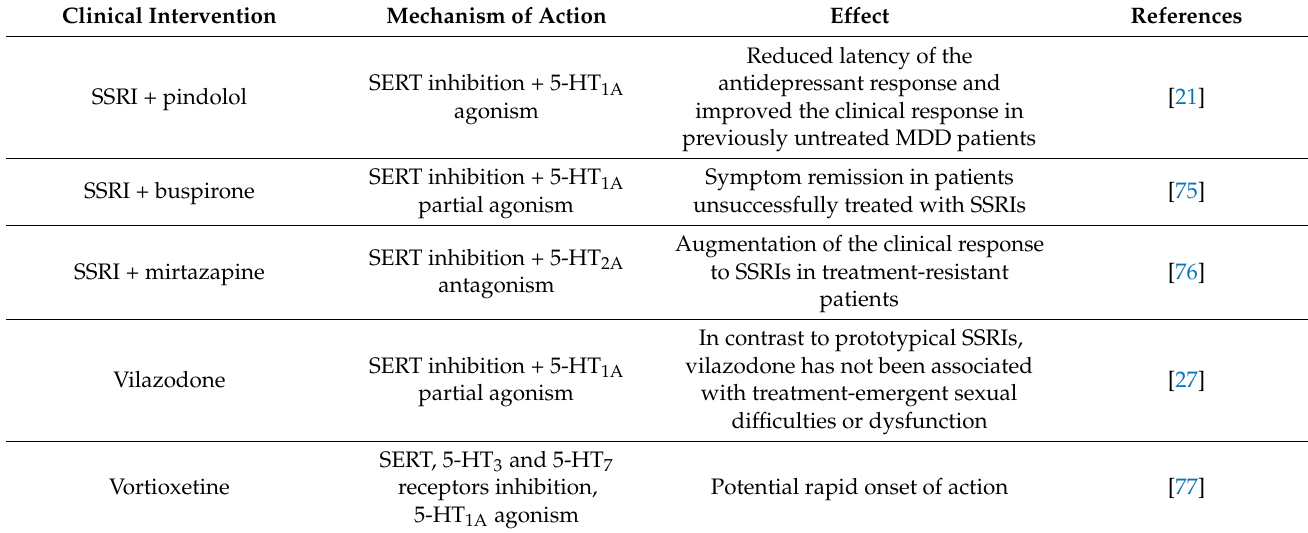
Table 1. Clinical effects of augmentation of SERT inhibition with different activities towards 5-HT receptors. Clinical Intervention Mechanism of Action